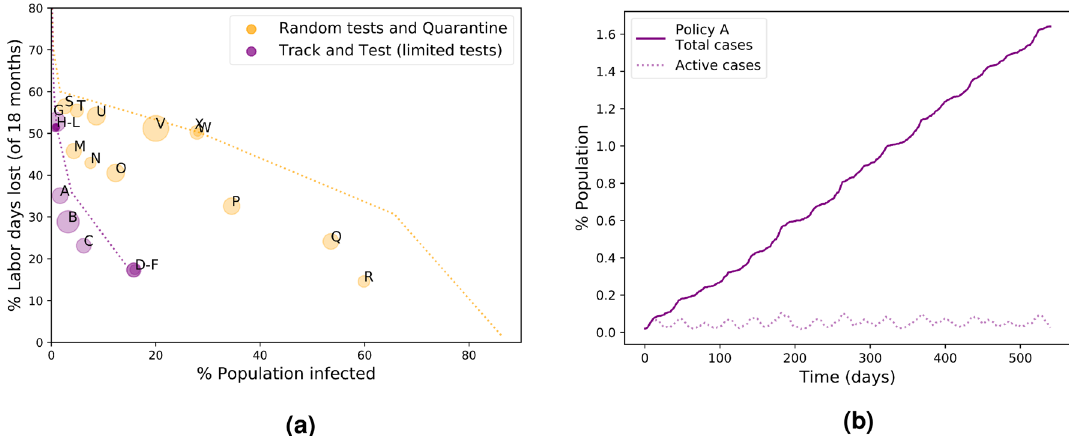
Figure 5. On–Off policies. (a) The cost map of the total percentage of labor days lost in 18 months versus the total percentage of population infected. The letters near the markers indicate the different policies as shown in Table 1. Purple markers are policies with the bounded Track and Test method and orange markers are with the Quarantine method with random tests. The purple and orange dotted curves show a comparison to the results of fixed lockdown policies with bounded Track and Test and with Quarantine and random tests, respectively. (b) The dynamics of the outbreak under policy A